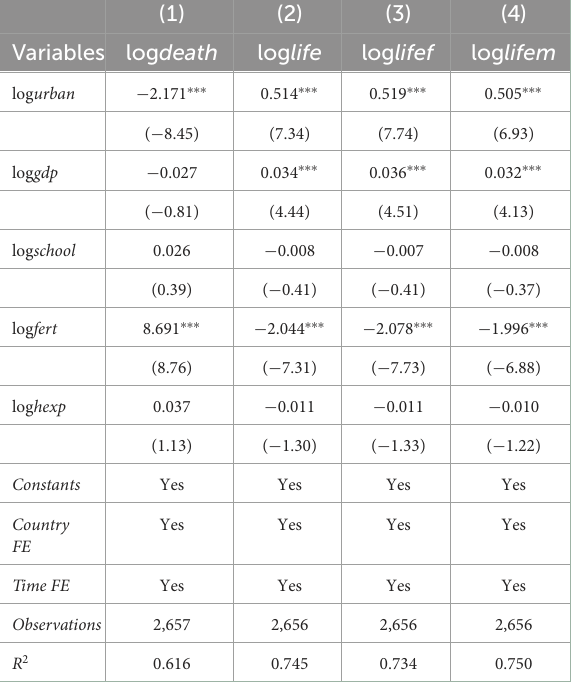
TABLE 8 IV estimation results.